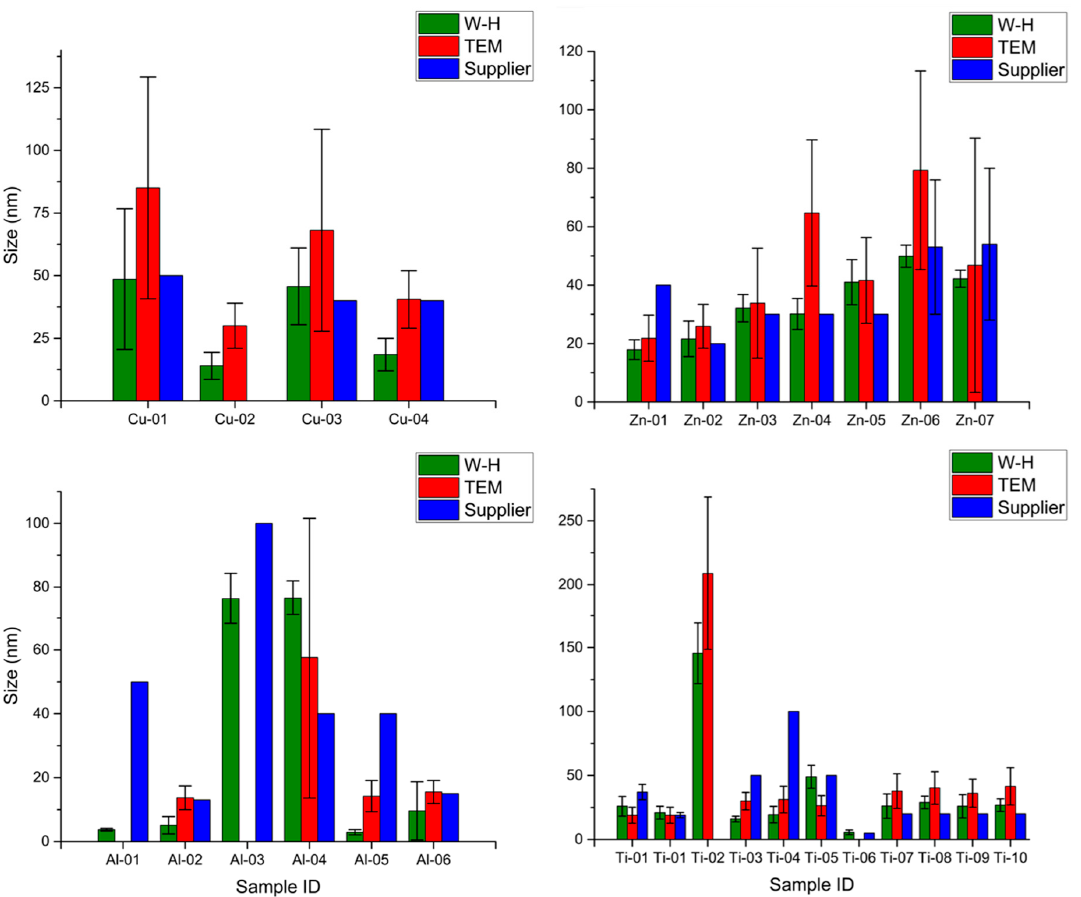
Figure 7. Comparison of nominal size reported by the supplier to the mean crystallite size from XRD and the TEM particle size distribution. The error bars for XRD are the standard deviation of the estimated size obtained from the Williamson-Hall linear regression, whereas for TEM they represent the standard deviation as a measure of the width of the particle size distribution. Nanowires (Al-07, Ti-11) are not included.